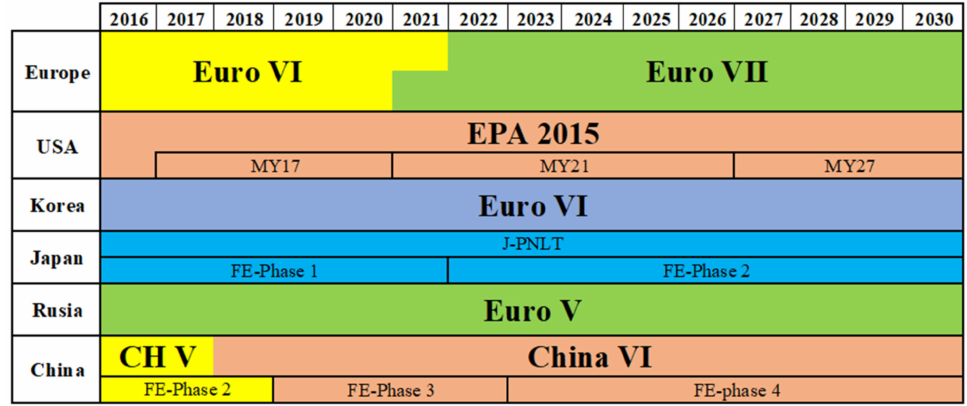
Figure 1. Emission regulation standards from all countries